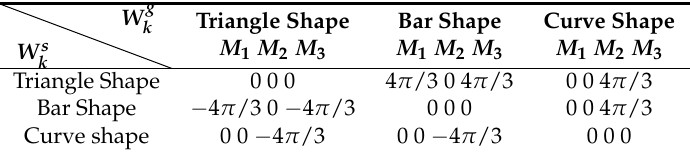
Figure 11. Three actions to move from source waypoint W s Table 1. The hTrihex module’s rotating φ i degree to shift the robot shape from source waypoint W s goal waypoint W g . k